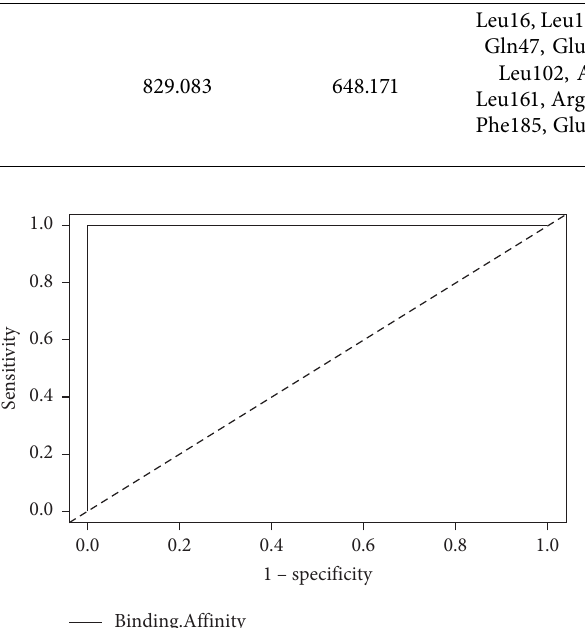
Figure 3: ROC plot generated by screening two active ligands and their decoys to the target protein structure, 5 α R-2. Te resulting AUC was found to be 1 classifed as